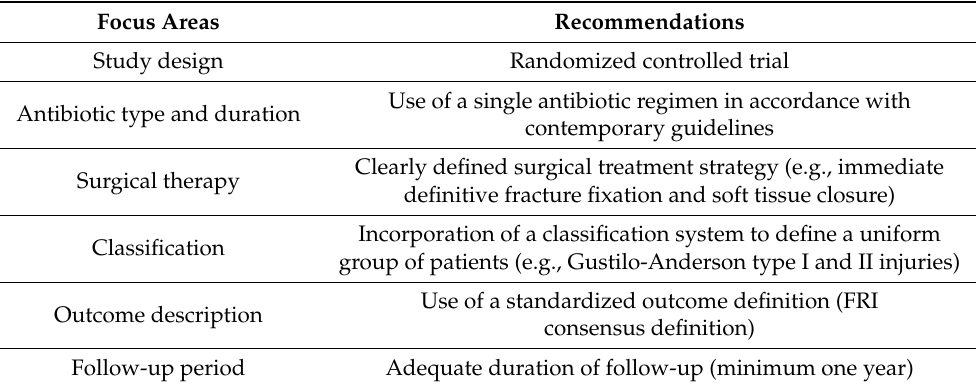
Table 2. Suggestions for the development of future